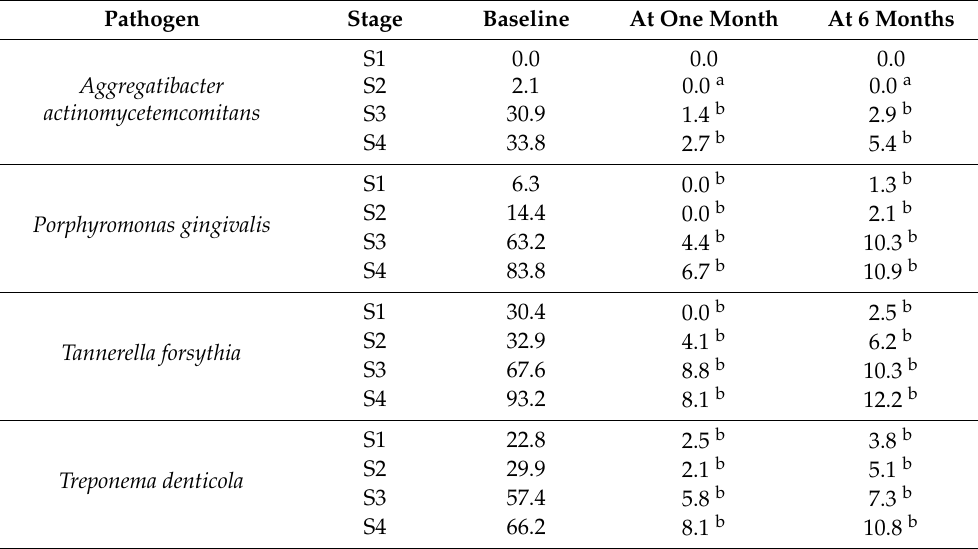
Table 7. Periodontal pathogens detection at baseline and after treatment (one month and six months) for the PDT group.